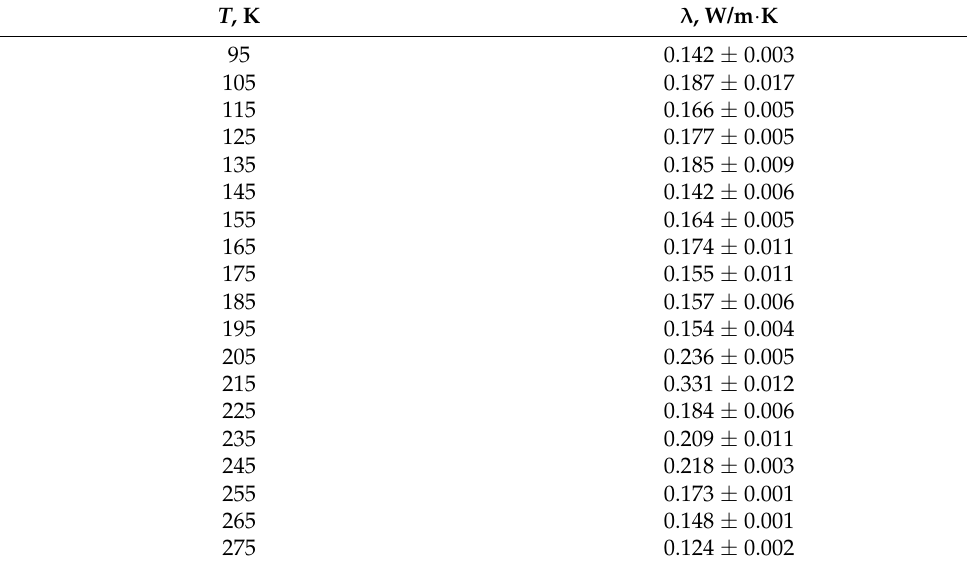
Table 1. Temperature dependence of thermal conductivity of a rubber sample. T , K λ , W/m · K